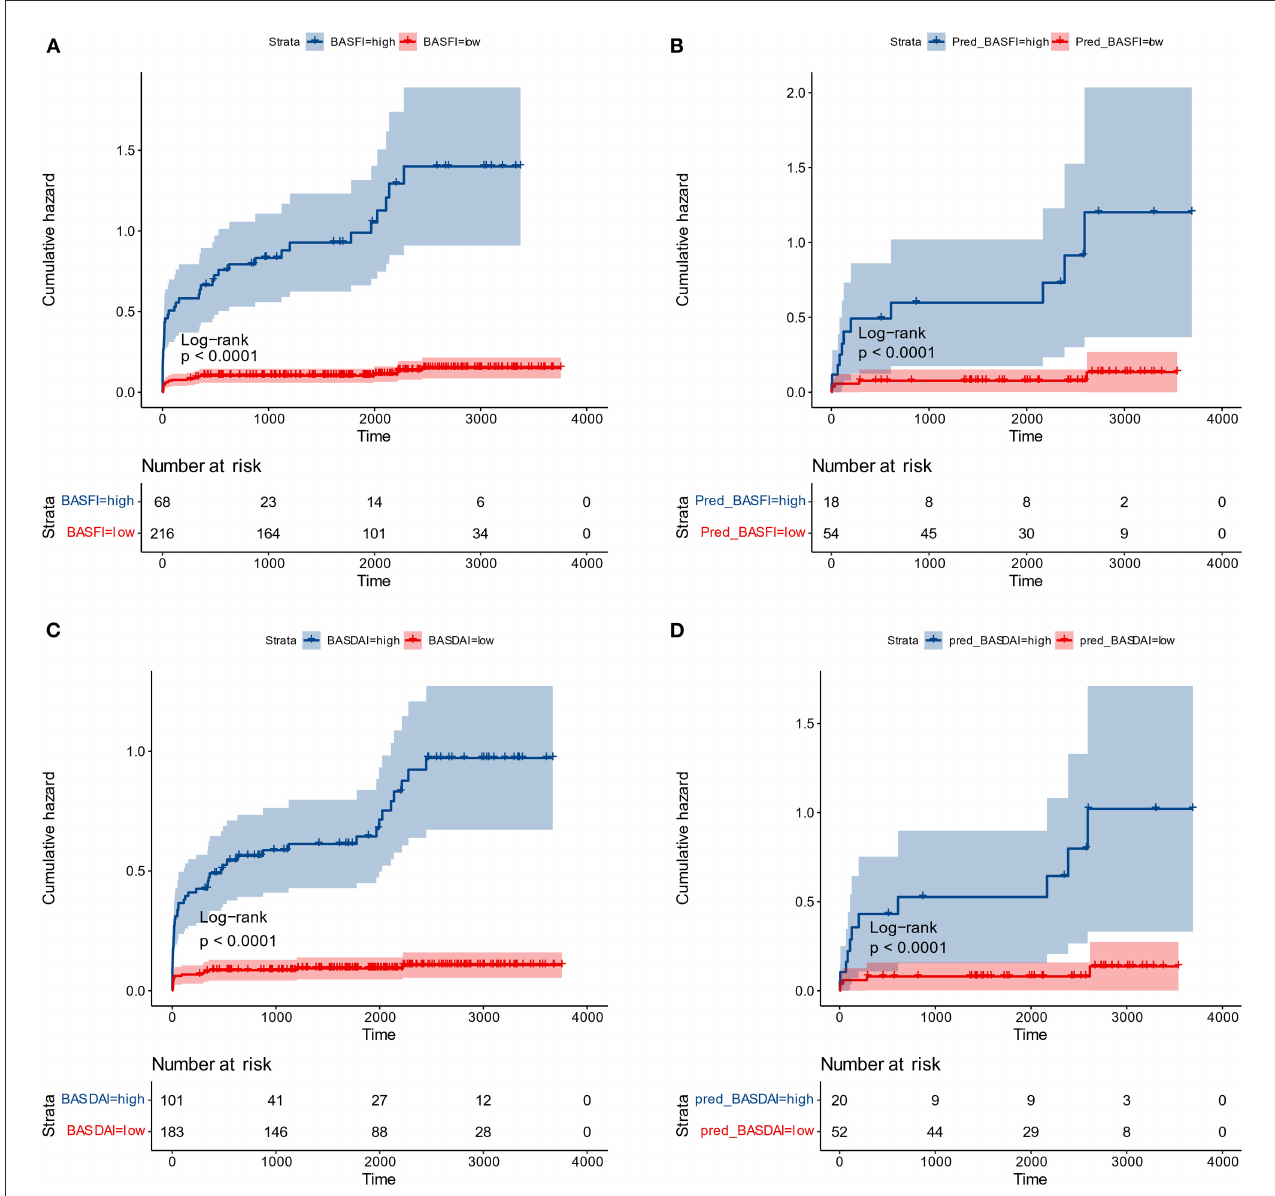
FIGURE7 Cumulative surgical risk curves. (A) Cumulative surgical risk curve for BASFI in the training dataset. (B) Cumulative surgical risk curve for BASFI in the test dataset. (C) Cumulative surgical risk curve for BASDAI in the training dataset. (D) Cumulative surgical risk curve for BASDAI in the test